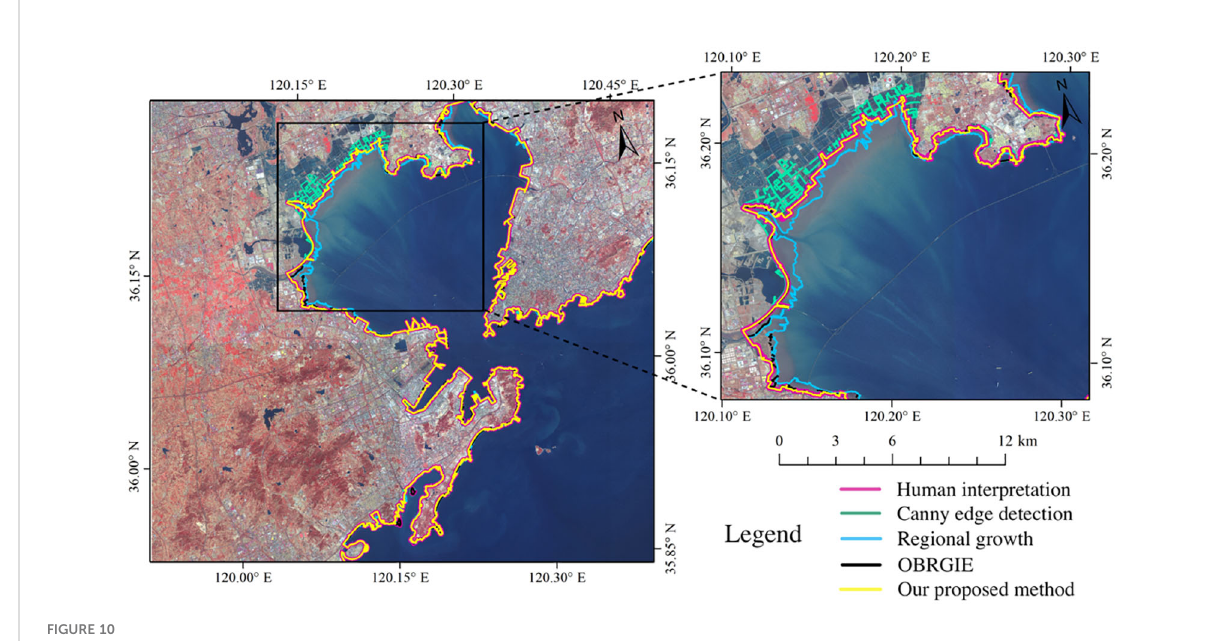
FIGURE 10 Coastline extraction results of different methods and comparisons.